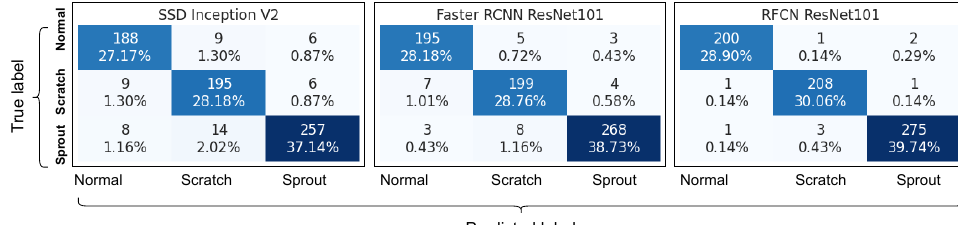
Figure 11. Confusion matrices for models evaluated on the test